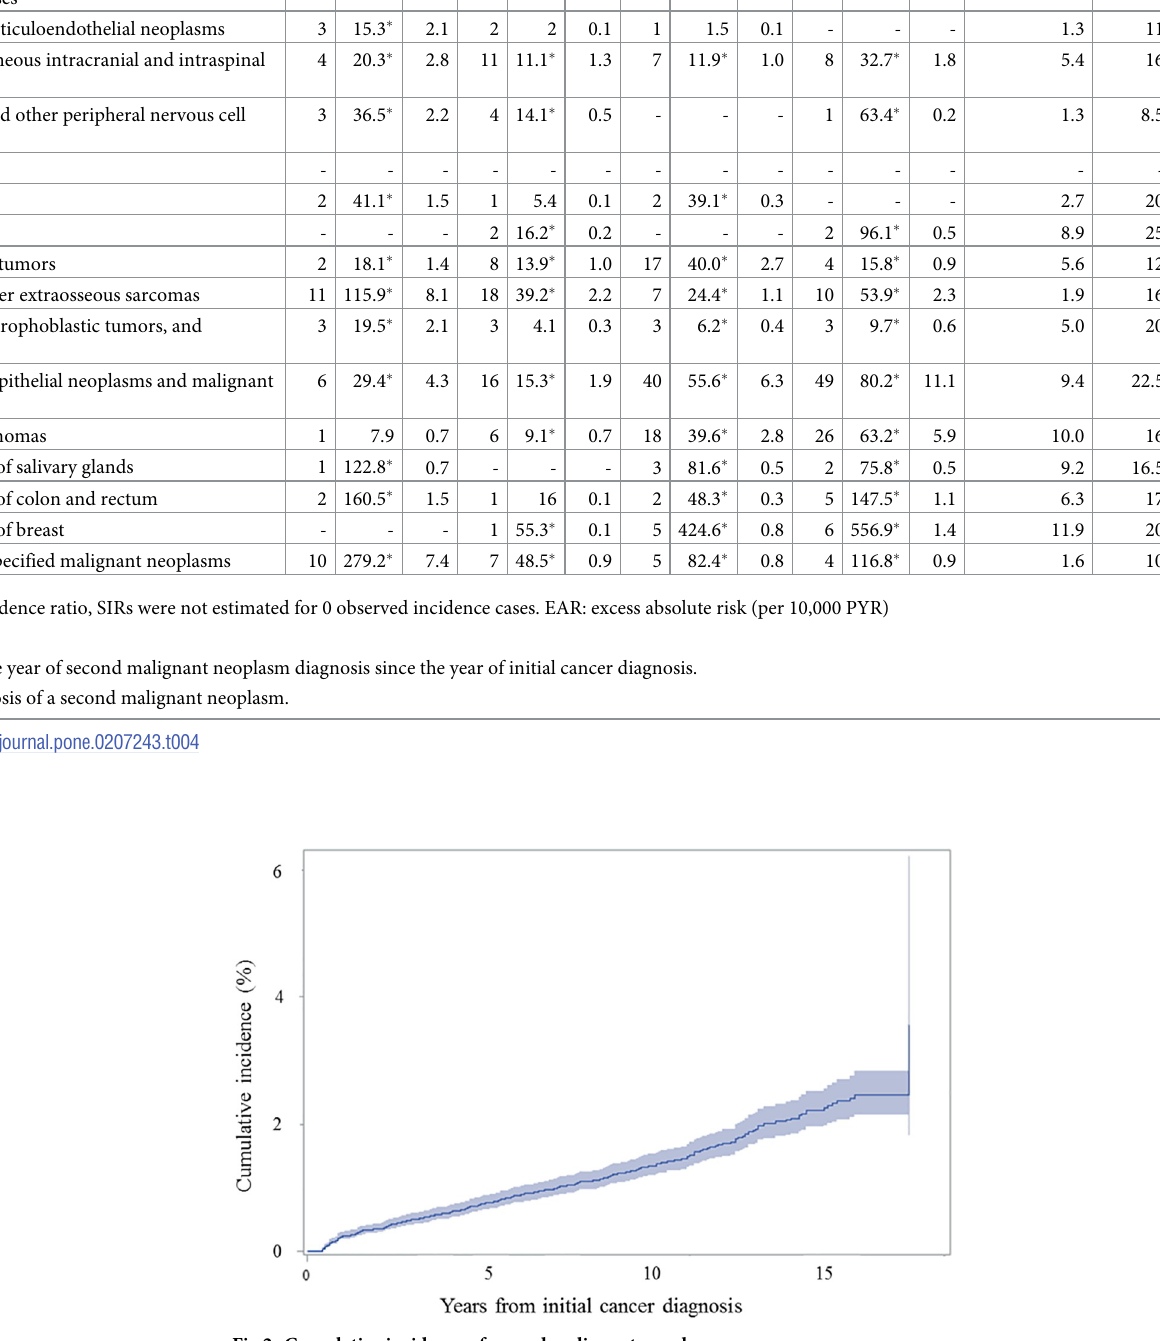
Fig 2. Cumulative incidence of second malignant neoplasms.